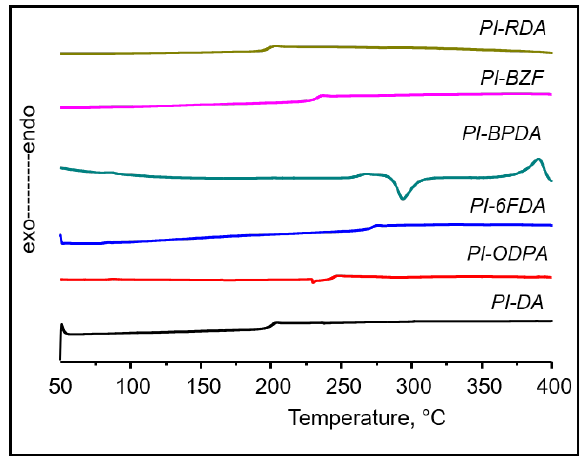
Figure 6. DSC curves of obtained PI. The second scanning. (in argon atmosphere, 10 °C/min).